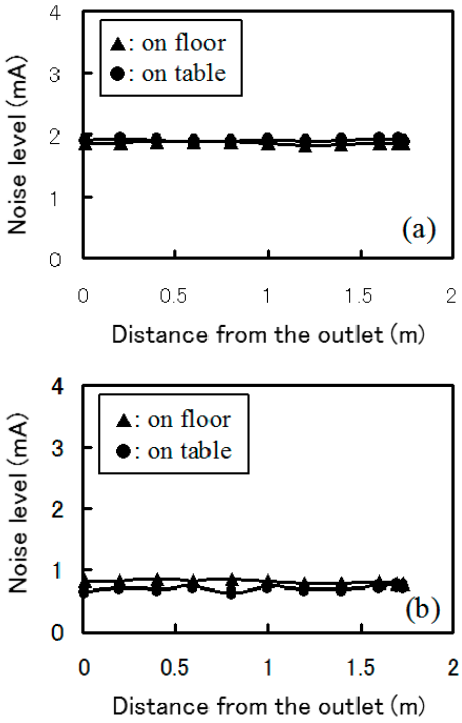
Figure 3. Dependences of the common-mode noise level on the distance from the monitor of the signal cables: ( a ) coaxial parallel series cable, ( b ) only coaxial cables: ( a ) coaxial parallel series cable, ( b ) only coaxial cable.